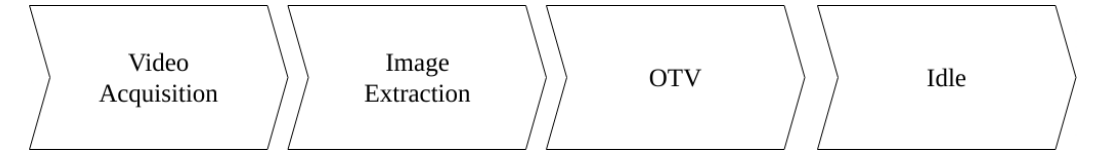
Figure 10. The four phases composing a measurement cycle.